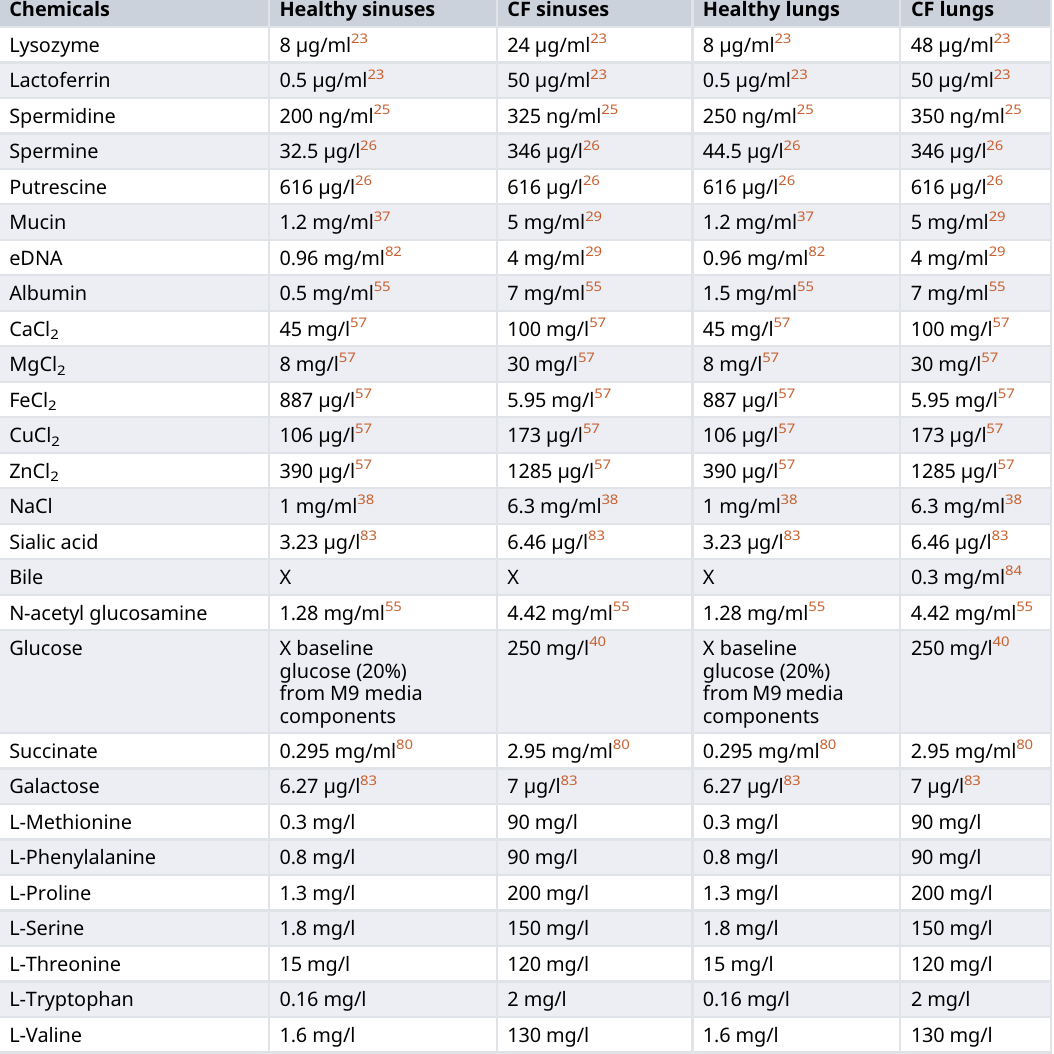
Table 3. Concentration of each chemical to be used in the final media. Amino acid concentration sources: healthy 81 : CF 21 : (x: chemical not present).